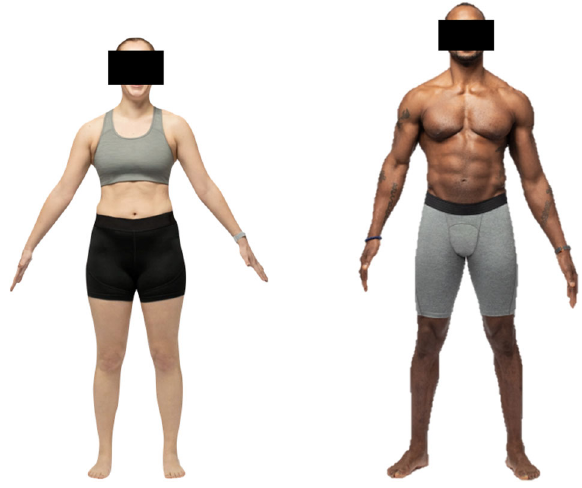
Fig. 6 Example smartphone images. The VBC algorithm requires images of the user ’ s front and back while wearing minimal clothing and holding an “ A ” pose as inputs to the